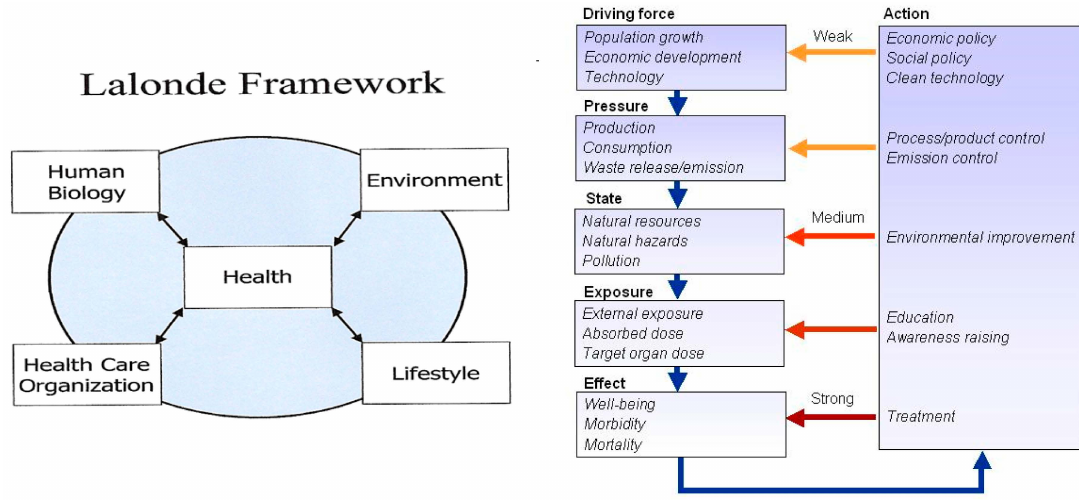
Figure 3. Common public health framework (left from [25]) and environmental sciences DPSEEA (Driving force, Pressure, State, Exposure, Effect and Action) causal chain framework (right, after [22] from [2]).